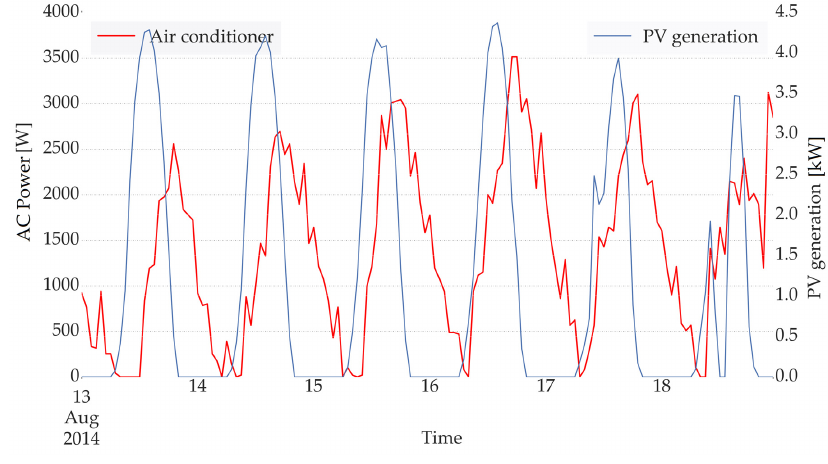
Figure 5. Correlation of irradiance and AC power.